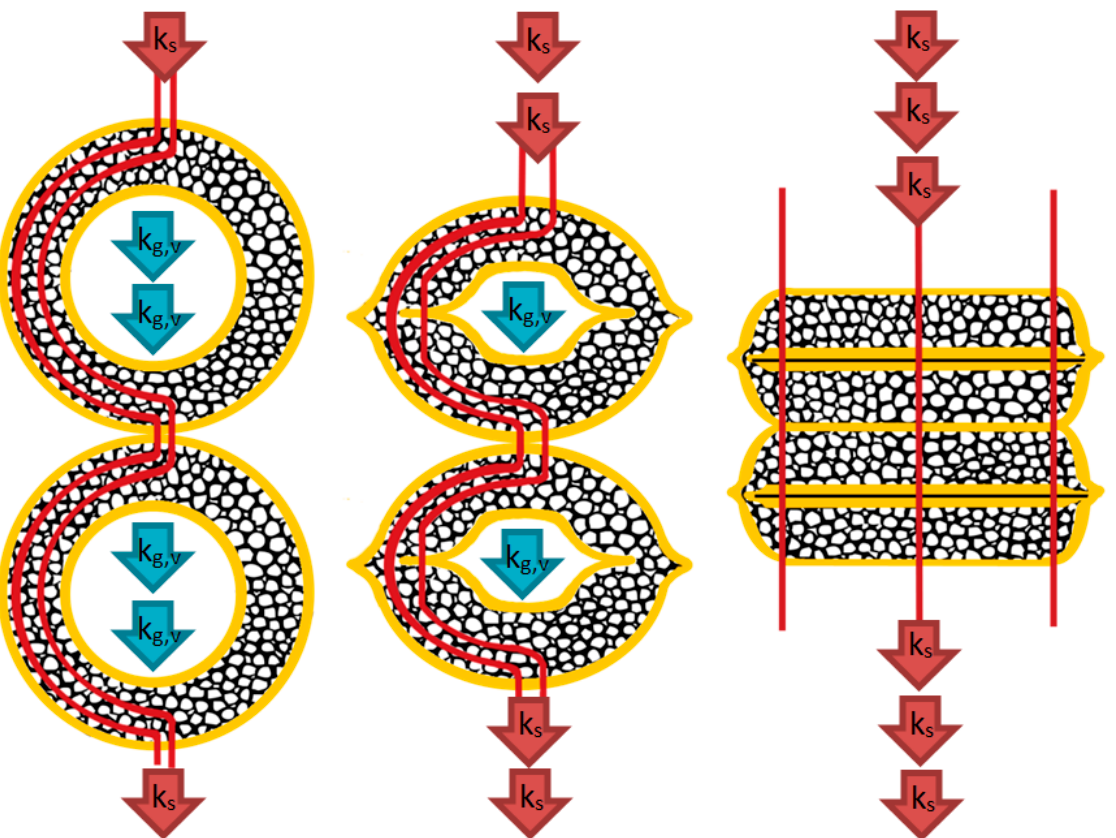
Figure 8. Effect of stem density on the length of heat path describing the idea of the flatness factor.